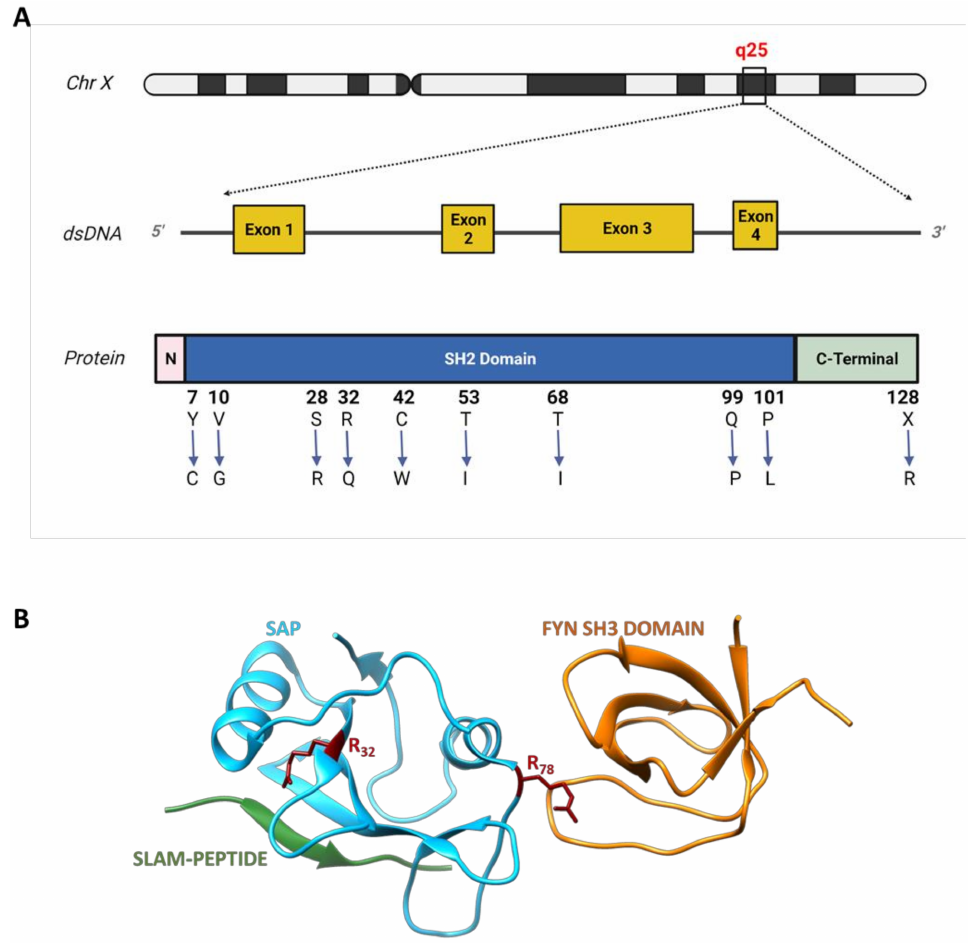
Figure 1. Schematic representation of SH2D1A gene with some missense mutations and the SAP protein structure. ( A ) The SAP gene and the corresponding protein are represented, showing an N-terminal (pink) region encoded by the exon 1, a central SH2 region (blue), encoded by exons 1,2 and 3 and a C-terminal region (light green) encoded both by exon 3 and 4 (exons are represented in yellow and indicated with a number in squares). Ten missense mutations on SAP SH2 and C-terminal domains affecting protein stability (Y 7 C, V 10 G, S 28 R, Q 99 P, P 101 L, X 128 R), and binding ability to both phosphorylated (R 32 Q, C 42 W) and unphosphorylated (R 32 Q, C 42 W, T 53 I, T 68 I) forms of SLAM are shown. ( B ) The 3D structure of SAP (light blue), in a trimeric complex with SLAM-PEPTIDE (green) and the SH3 domain of Fyn (orange) is showed [27]. The two arginine residues in positions 32 and 78, are shown (red) which are reported to play a critical role in the binding with SLAM and Fyn,